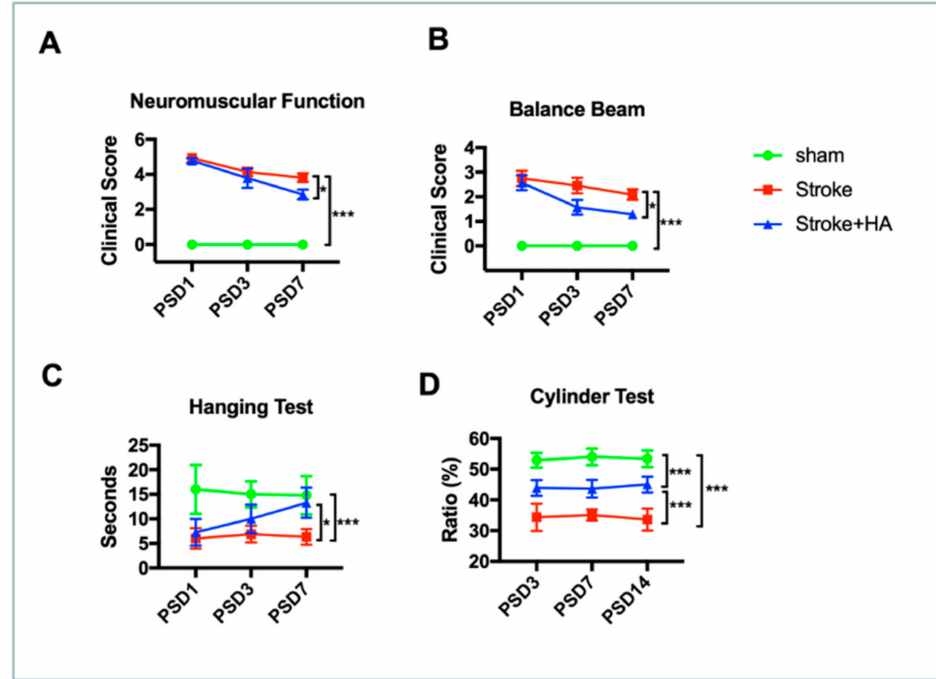
Figure 7. HA treatment improved the behavioral outcomes of rats after ischemic stroke. ( A ) Data of mNSS were acquired from rats with ischemic stroke at post-stroke day (PSD) 1, 3, 7. ( B ) Data of balance beam test were acquired from rats with ischemic stroke at PSD 1, 3, 7. ( C ) Data of hanging test were acquired from rats with ischemic stroke at PSD 1, 3, 7. ( D ) Data of cylinder test were acquired from rats with ischemic stroke at PSD 1, 3, 7. n = 8. * Denotes p < 0.05, *** denotes p <